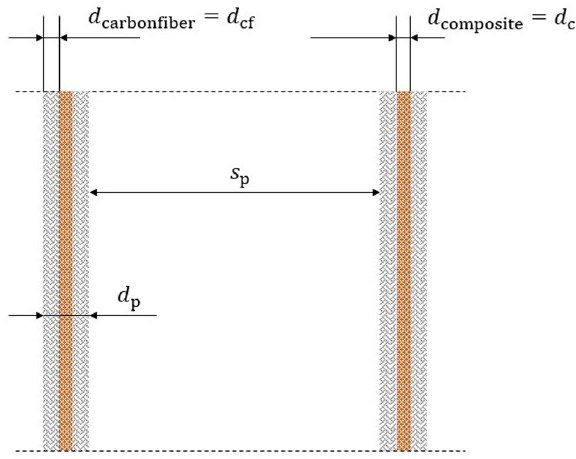
Figure 5. Curtain cross